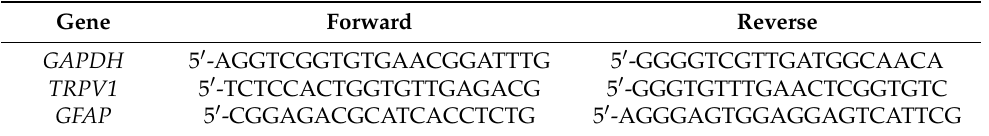
Table 2. Polymerase chain reaction (PCR)